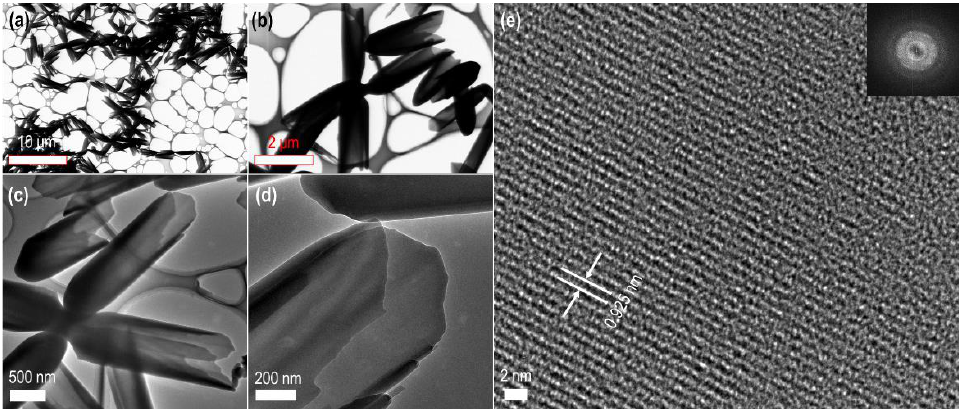
Figure 2. Electron microscopy observations of the CHFCs: ( a , b ) STEM images; ( c , d ) TEM images; ( e ) HR-TEM image with a selected area diffraction pattern in the inset.